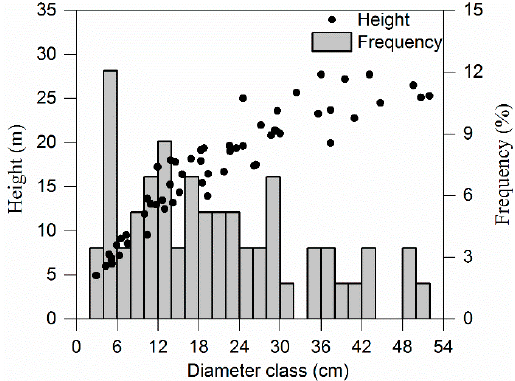
Figure 2. Tree h against dbh for destructively sampled trees. The vertical bars represent the sample frequency across 2-cm diameter classes.